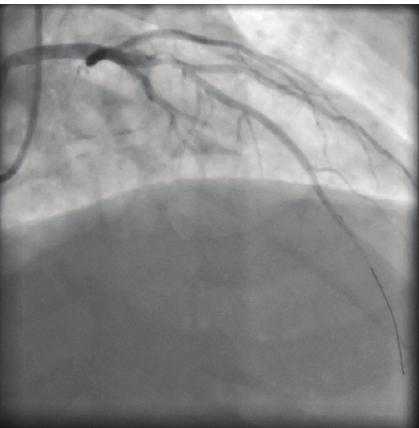
Figure 1: Tight proximal left anterior descending artery stenosis fol- lowing wiring and attempted thrombus extraction.